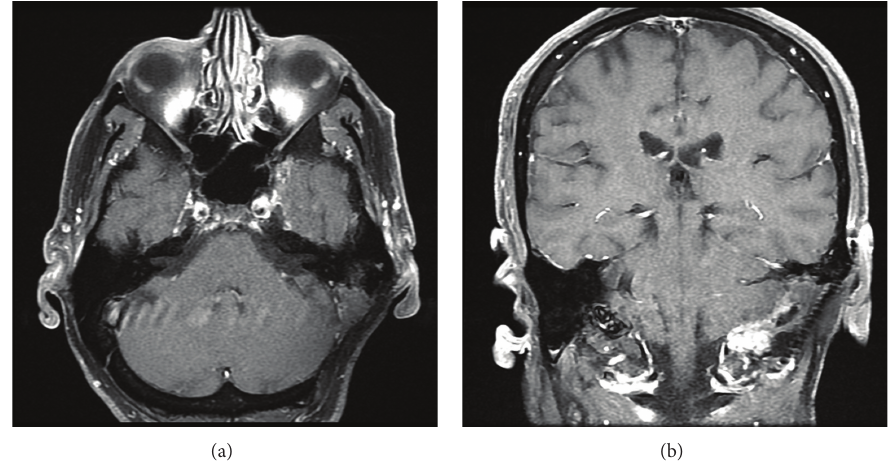
F4:AgadoliniumenhancedandfatsuppressedT1(a)axialand(b)coronaldemonstratingarecurrentmastoidmasswithintheprevious resection